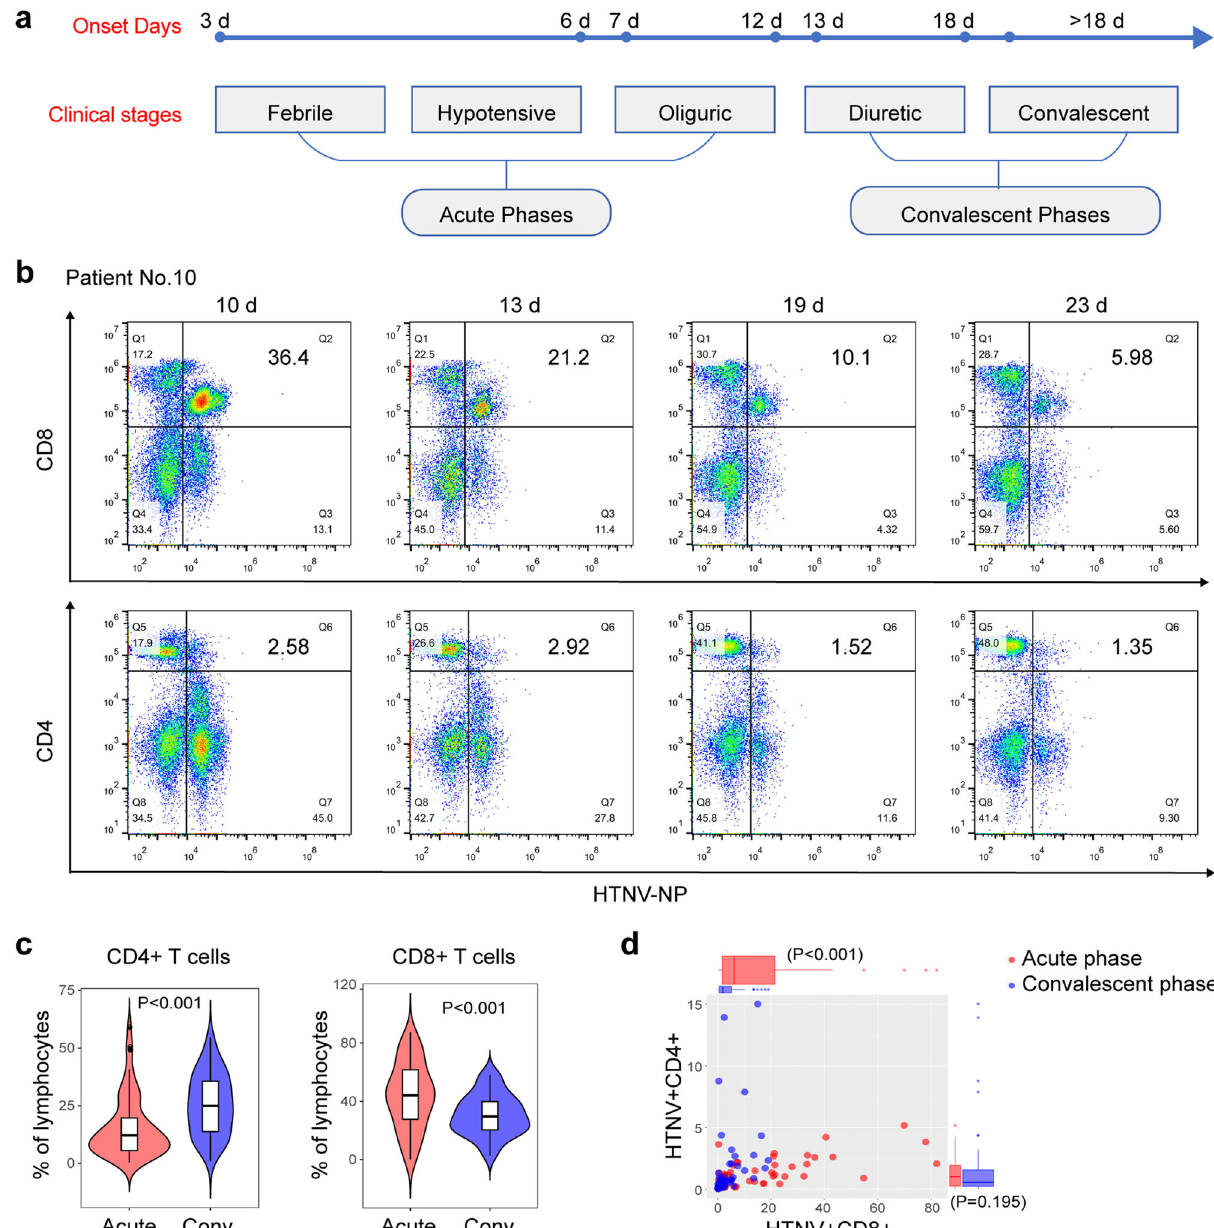
Fig. 1 Characterization of virally infected T lymphocytes from HRFS patients at various stages of the disease. a Classi fi cation of disease stages of HFRS patients. b Representative FACS plots of viral infection (HTNV-NP positive) of CD4 + and CD8 + T cells in PBMC samples obtained from HFRS patient No. 10 on days 10, 13, 19, and 23 after symptom onset. c Comparison of the percentages of CD8 + T cells (top panel) and CD4 + T cells (bottom panel) between the acute and convalescent phases of HFRS. (Acute, n = 62; Conv., n = 60). d Comparison between the frequency of HTNV-infected CD8 + T cells and CD4 + T cells during the acute and convalescent phases of HFRS. Each point represents a single sample; red indicates the acute phase and blues the convalescent phase. Groups were compared using a two-tailed unpaired Student ’ s t -test. (Acute, n = 62; Conv., n =